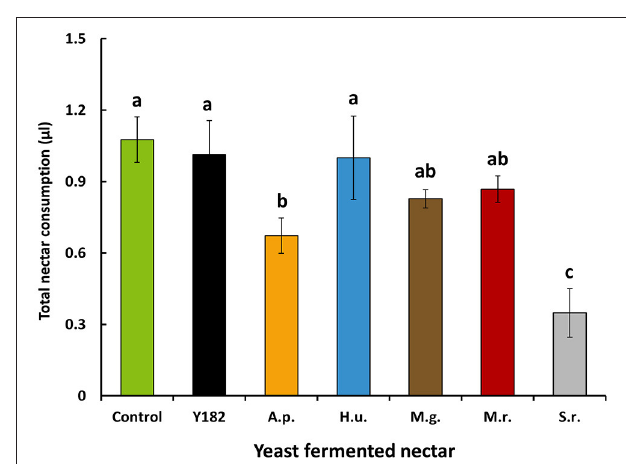
FIGURE 3 | Mean nectar intake ( ± SE, n = 5, each with 15 individuals per cage) by feeding-inexperienced adult Aphidius ervi parasitoids after 9h of nectar supply. Parasitoids were provided different nectars, including: Control, non-inoculated, yeast-free nectar; Y182, nectar fermented with the reference strain Saccharomyces cerevisiae Y182; A.p., Aureobasidium pullulans -fermented nectar; H.u., Hanseniaspora uvarum -fermented nectar; M.g., Metschnikowia gruessii -fermented nectar; M.r., Metschnikowia reukaufii -fermented nectar; S.r., Sporobolomyces roseus -fermented nectar. Experiments were performed using cell-free nectar solutions. Different letters above colored bars indicate significant differences between provided nectars ( P < 0.05), based on Student-Newman-Keuls method ( F